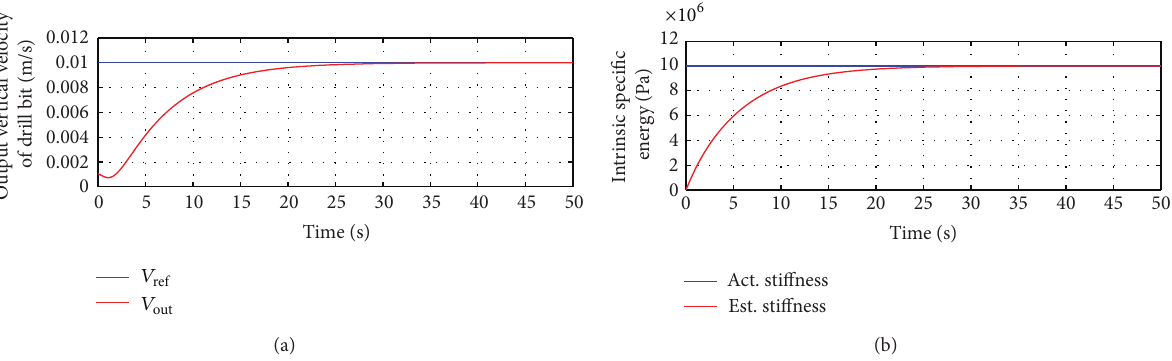
Figure 11: Response of the vertical velocity V (𝑡) (a) and the intrinsic specific energy estimate ̂𝜖(𝑡) (b) for 𝑊 0 = 2500 N, 𝜖 = 10 MPa, and = 5 ⋅ 10 8 𝛾 0